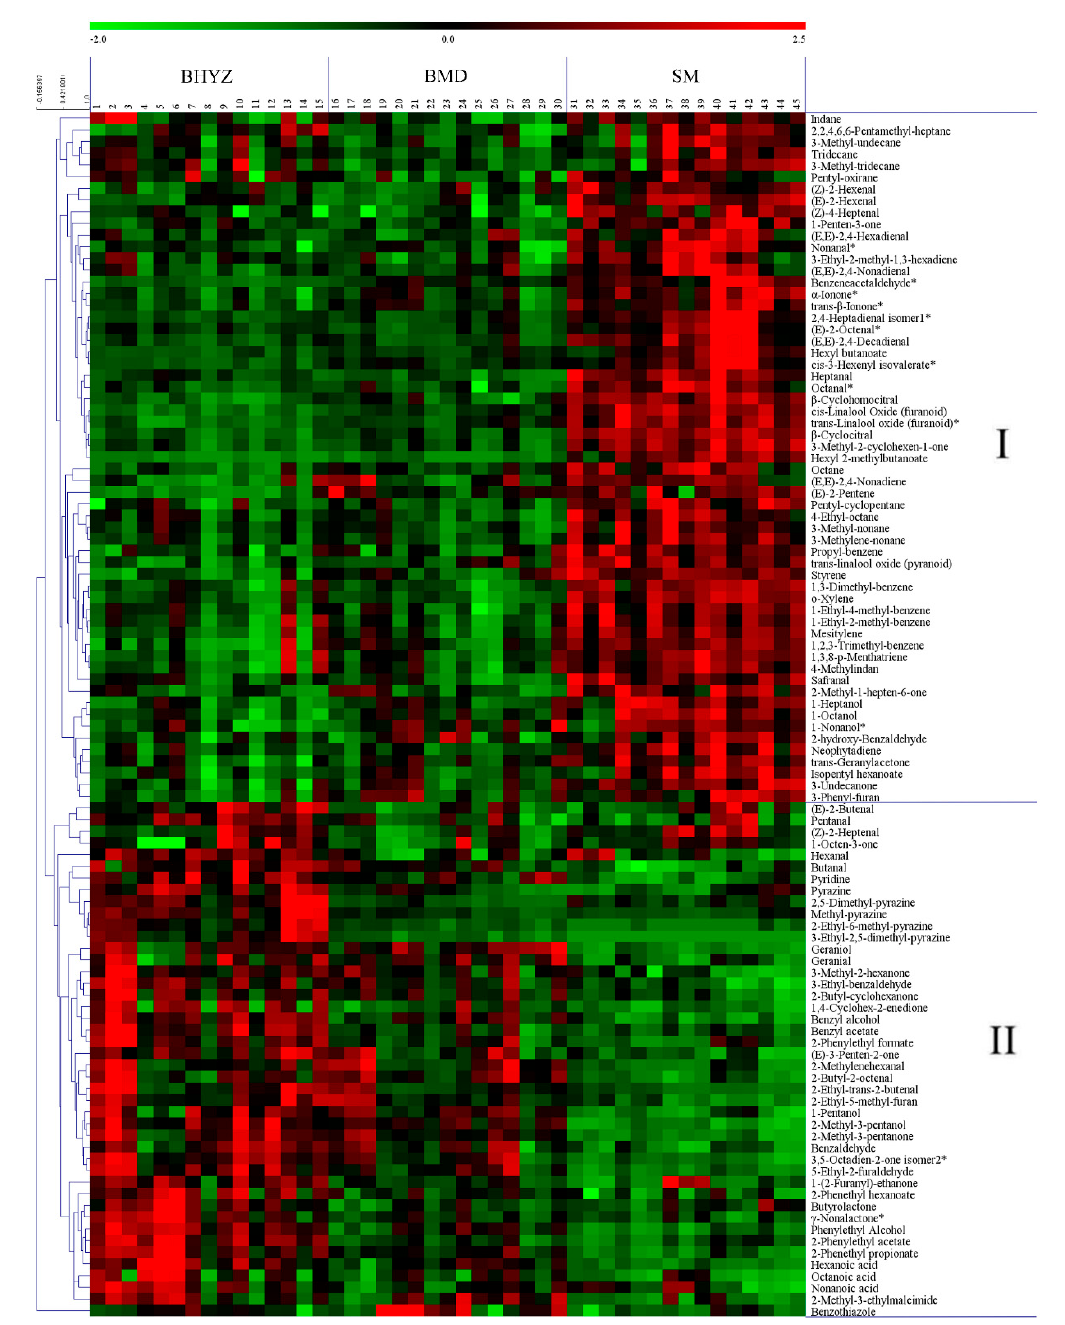
Figure 3. Heat map of the contents of significantly di ff erential volatile compounds in white teas. The data were